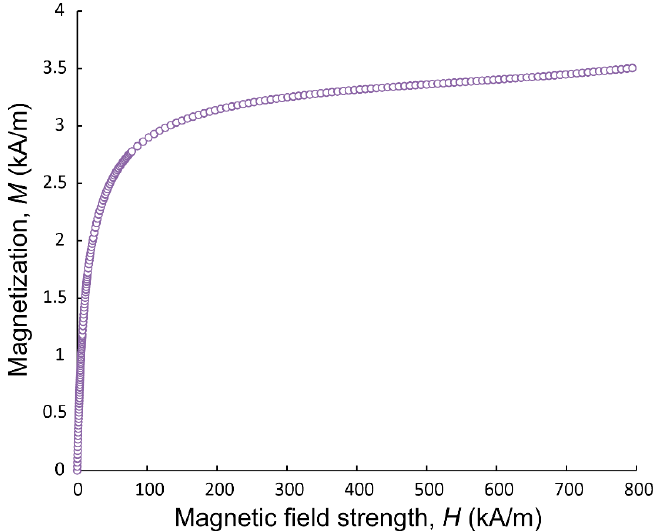
Figure 1. Magnetization curve of magnetic nanofluid used in the experiments.